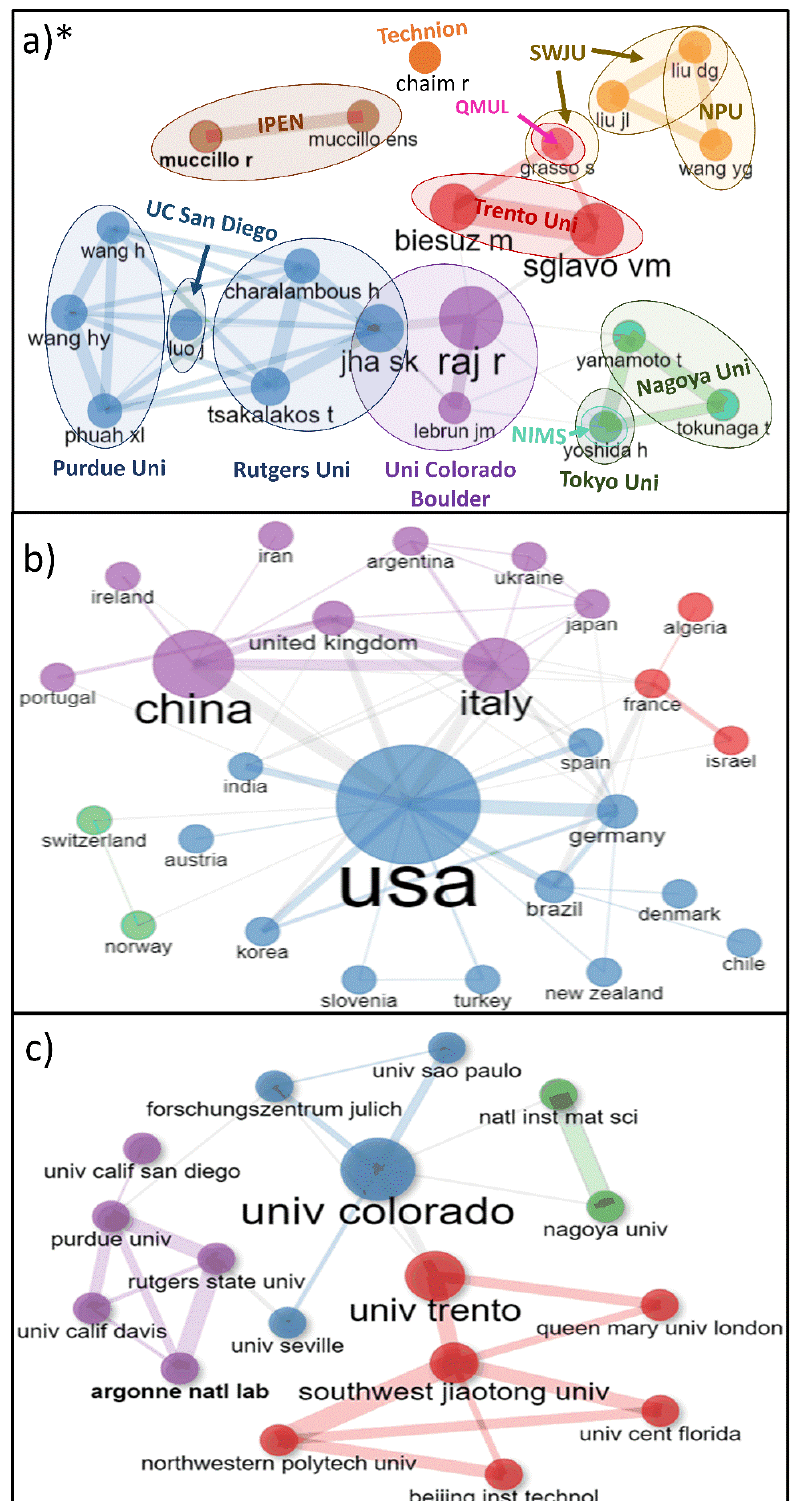
Figure 3. ( a ) Selected authors from Table 2, ( b ) countries, and ( c ) institution’s collaboration net-